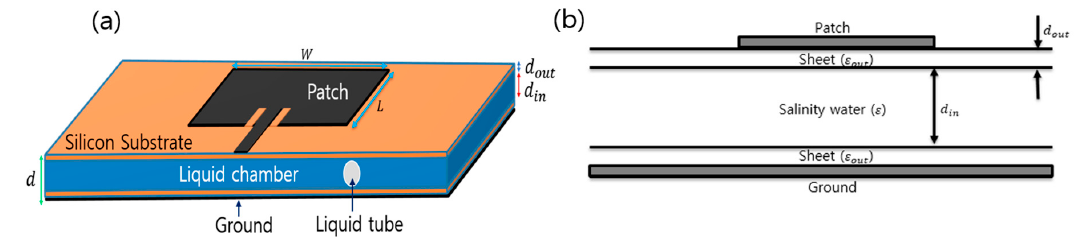
Figure 2 . ( a ) Geometry of the microstrip patch resonator; ( b ) Structure of the proposed salinity sensor.